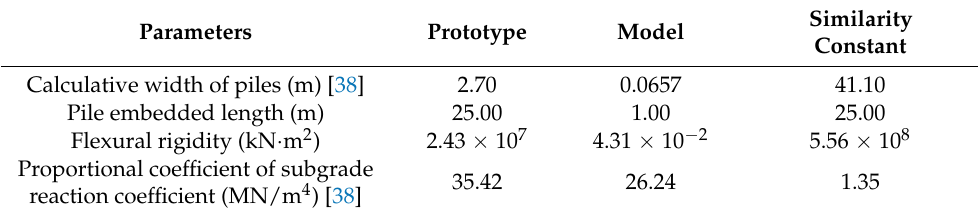
Similarity Constant